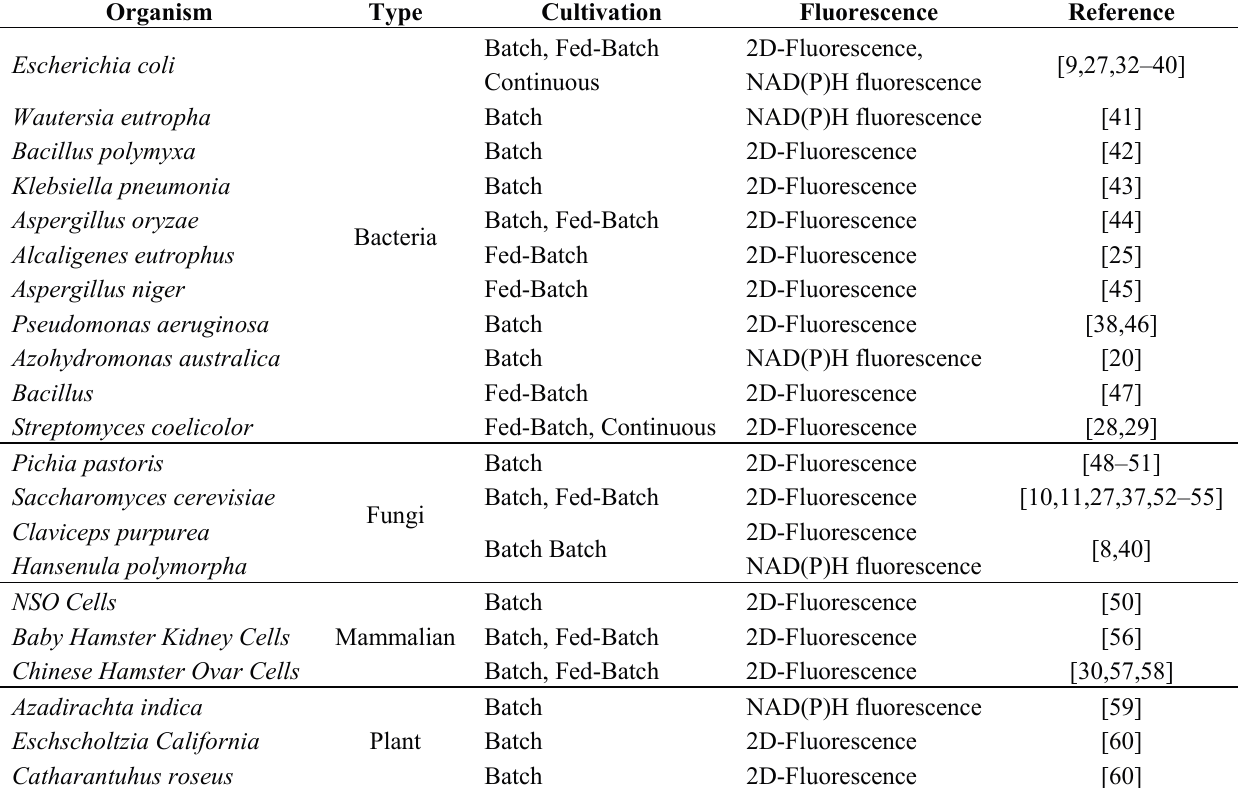
Table 1. Applications of fluorescence spectroscopy for cultivation processes.